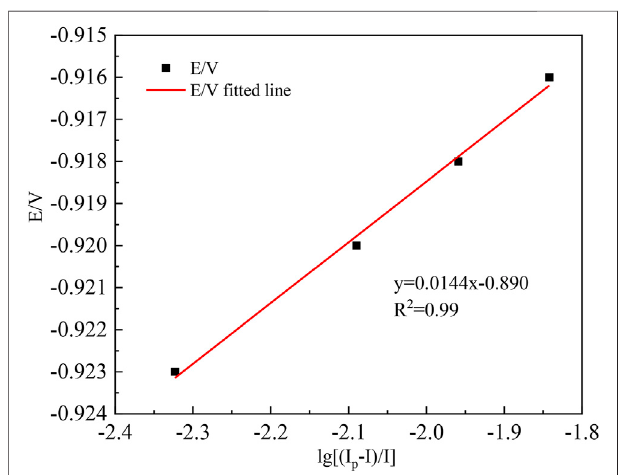
FIGURE 2 | Graph of the E – lg [( I p - I )/ I ] relationship (30 mV/s).